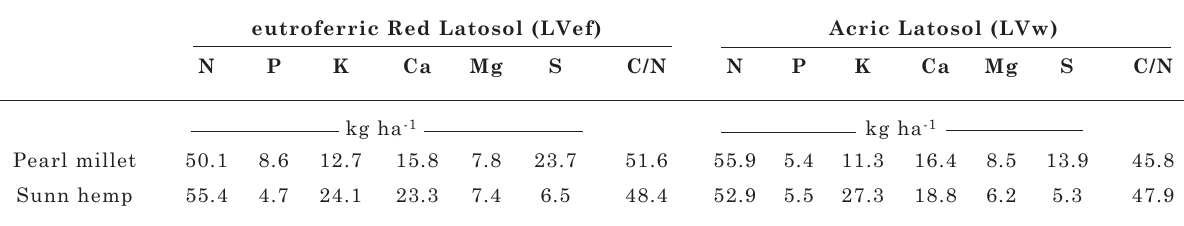
table 4. residue nutrient accumulation and c/n ratio after pearl millet and sunn hemp harvest